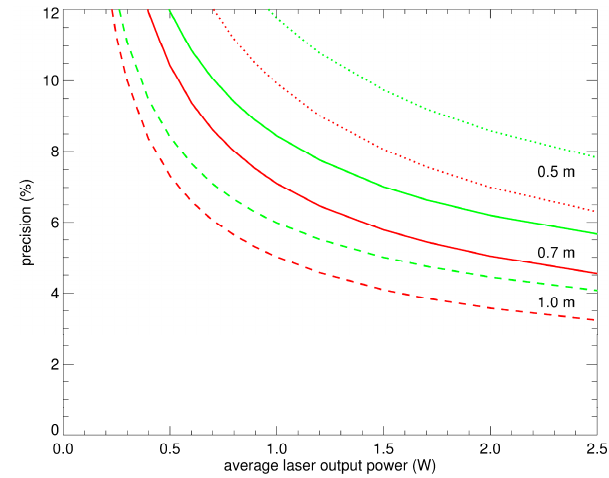
Figure 4. XCO 2 (1.57 µm; red) and XCH 4 (1.65 µm; green) precision at sea level (noise error) as function of average laser power and telescope diameter (dotted: 0.5 m; solid, baseline: 0.7 m; dashed: 1.0 m) for space based Lidar profiling under the conditions of Tables 1 and 2.